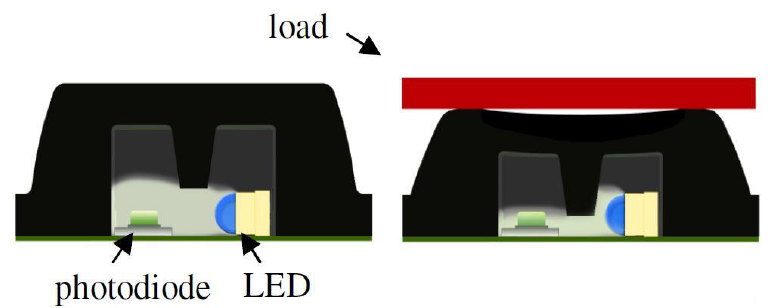
Figure 33. Working principle of De Rossi et al. sensor.